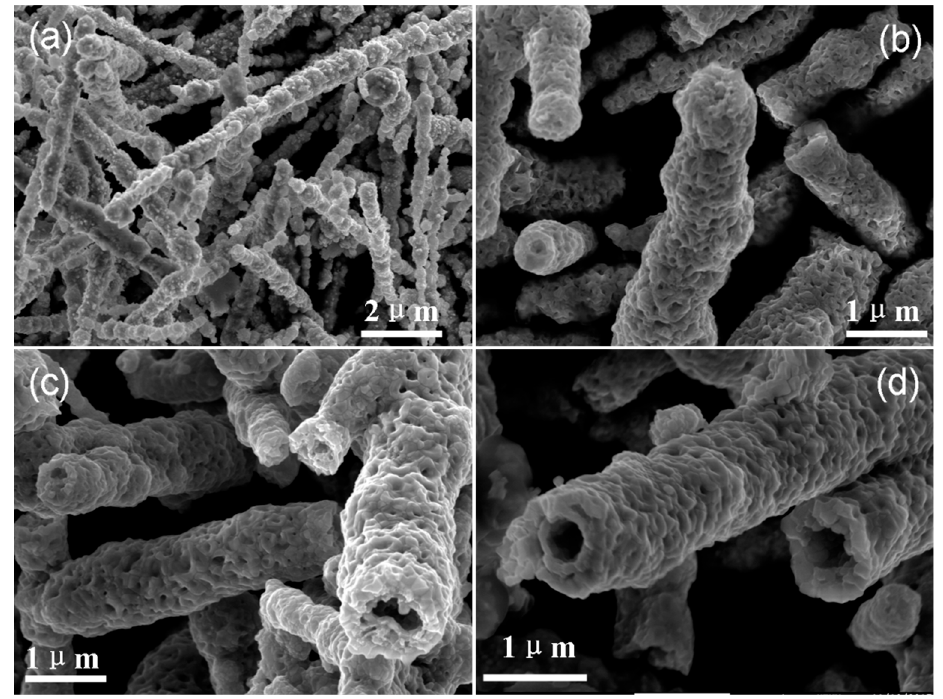
Figure 1. SEM images of ( a ) as-prepared Ni NWs, ( b – d ) Ni NWs annealed at 400, 500, and 600 ◦ C,